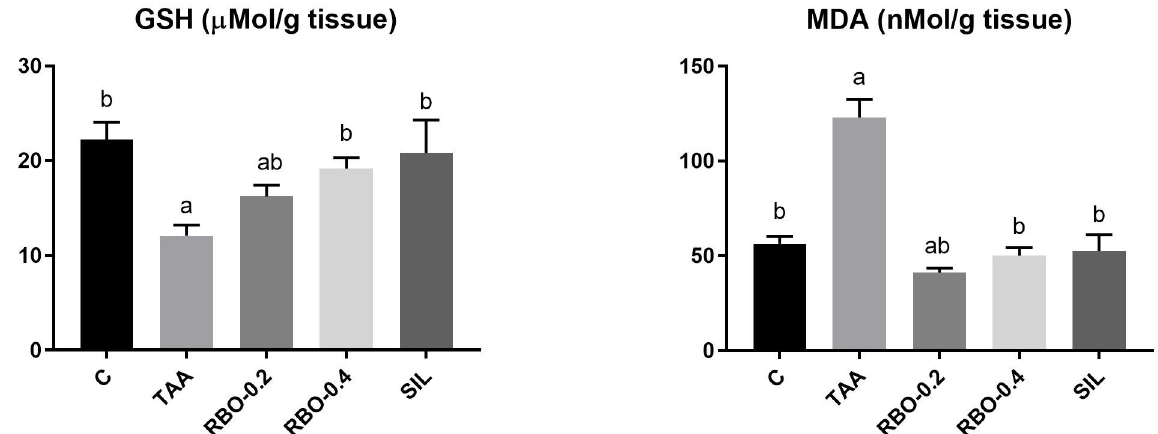
Fig 3. Effect of RBO on tissue levels of GSH and MDA in TAA-induced liver fibrosis in rats. Control rats, treated with saline; TAA rats, treated with thioacetamide (100 mg/kg; three times per week for 2 weeks, ip ); RBO rats, treated with TAA and RBO (0.2 and 0.4 mL/rat; daily for 2 weeks, po ) and silymarin (100 mg/kg, po ). All data are presented as Mean ± SEM, (n = 6). a P � 0.05 was assumed to denote statistical significance compared to the negative control, b P � 0.05 was assumed to denote statistical significance compared to TAA group. TAA, Thioacetamide; RBO, Rice bran oil; GSH, Reduced glutathione; MDA, Malondialdehyde.